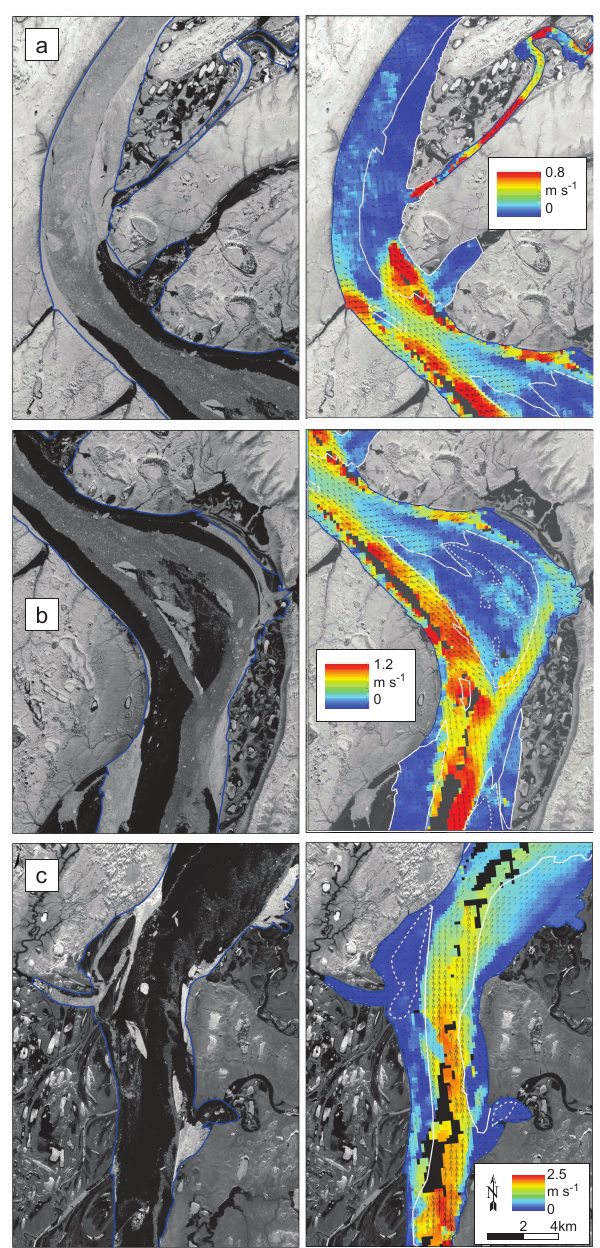
Fig. 7. Raw ASTER satellite imagery of 27 May 2011 used for ice tracking (left column) and velocity fields measured (right column). Sand bars (solid white lines) and vegetated islands (dotted white lines) from low-water conditions as of 21 August 2011. Speeds are colour coded. Velocity vectors (originally a 165m × 165m grid) are resampled to a 330m × 330m grid for better visibility. For locations of sites (lower-case letters) see Figs. 4 and